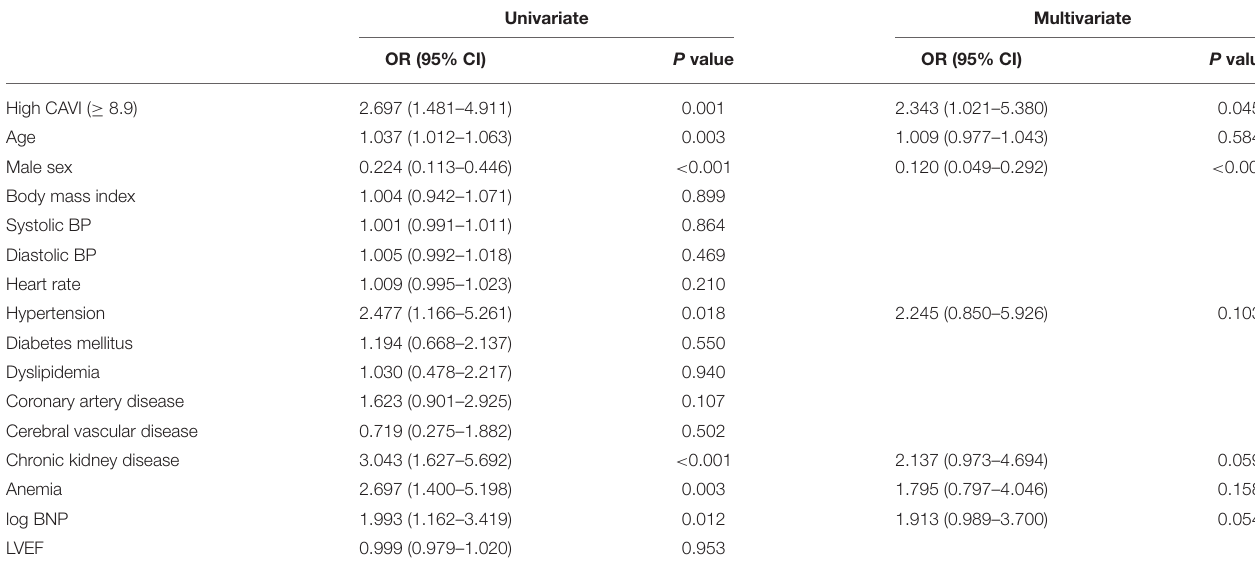
TABLE 2 | Logistic regression analysis for predicting impaired peak VO 2 . Univariate Multivariate OR (95% CI)